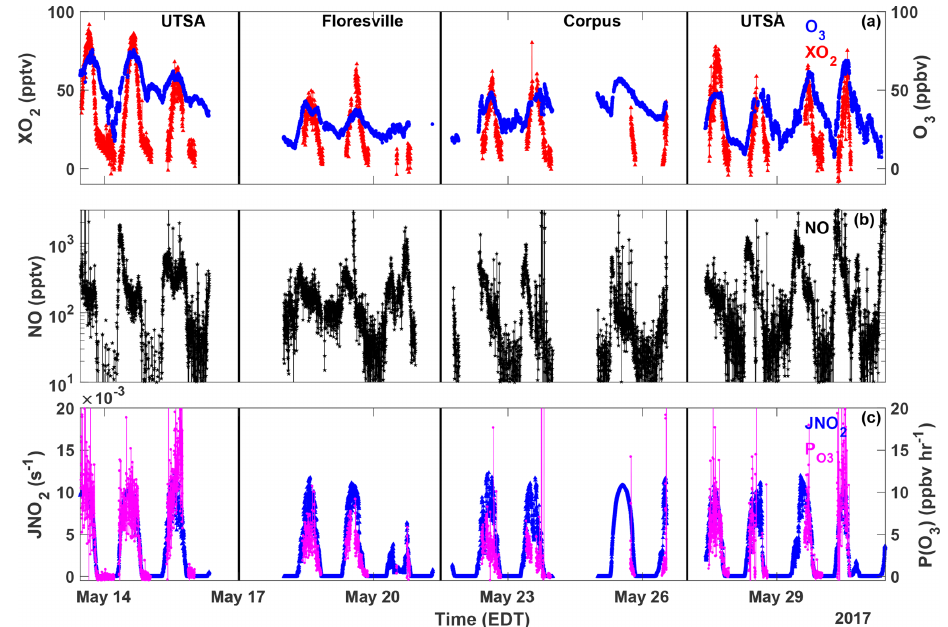
Figure 3. Time series of O 3 (blue circles), X O 2 (red triangles), NO (black stars), J NO 2 (blue triangles), and P( O 3 ) (magenta circles) measured at all sites. All data are averaged over the X O 2 sampling period.